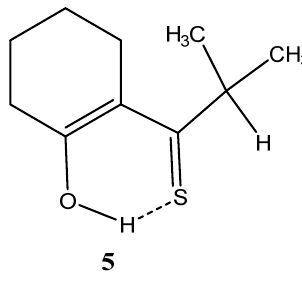
Figure 10. Structure of compound 5 .